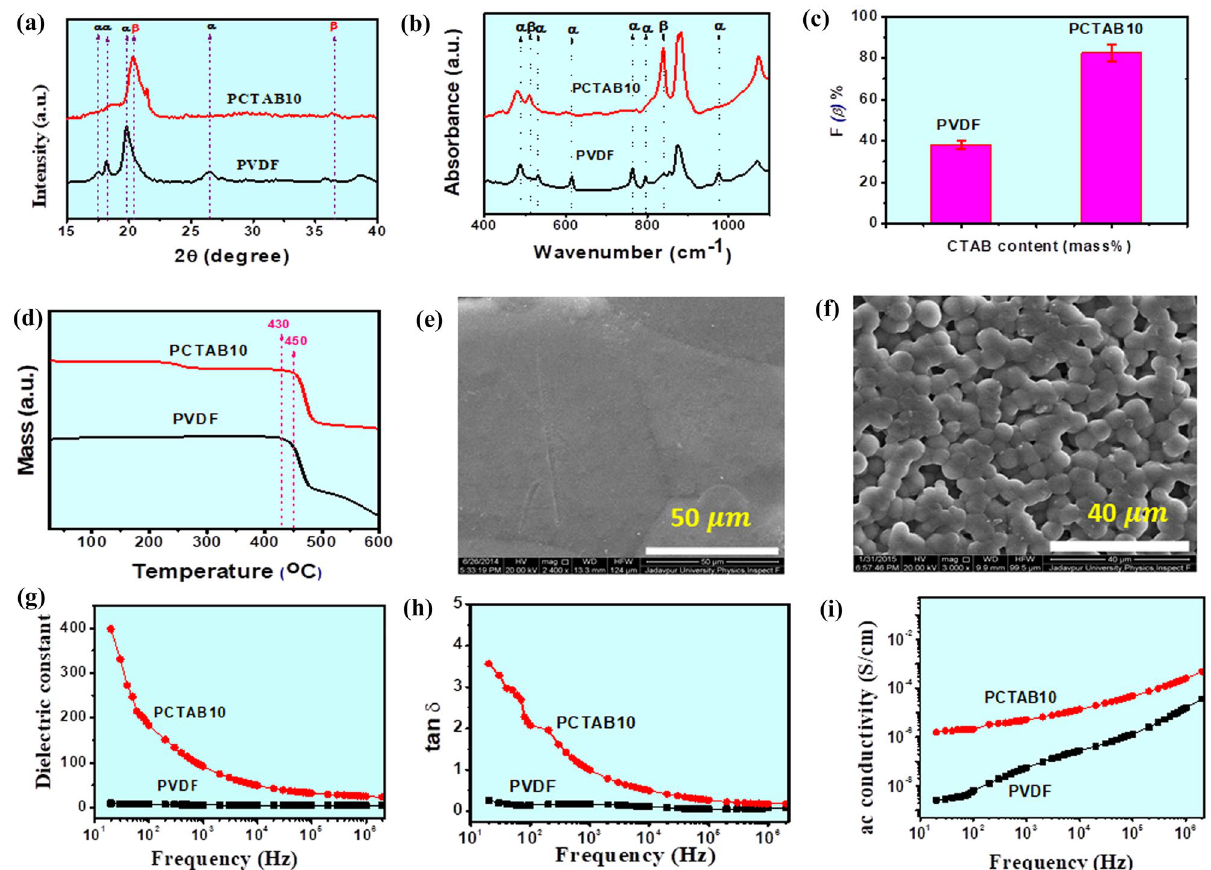
Figure 1. ( a ) X-ray diffraction patterns of pure PVDF and CTAB incorporated PVDF composite thin films, ( b ) FTIR spectroscopy of pure PVDF and PCTAB10 thin films ( c ) β-phase content of PCTAB10 composite sample with pure PVDF from FTIR spectra ( d ) TGA thermographs of pure PVDF and 10% CTAB modified PVDF thin films for investing the thermal stability, ( e, f ) FESEM microstructures of pure PVDF and CTAB modified PVDF films, Variation of the ( g ) dielectric constant, ( h ) ac conductivities, ( i ) tangent loss with frequency of pure PVDF and PCTAB10 composite films.